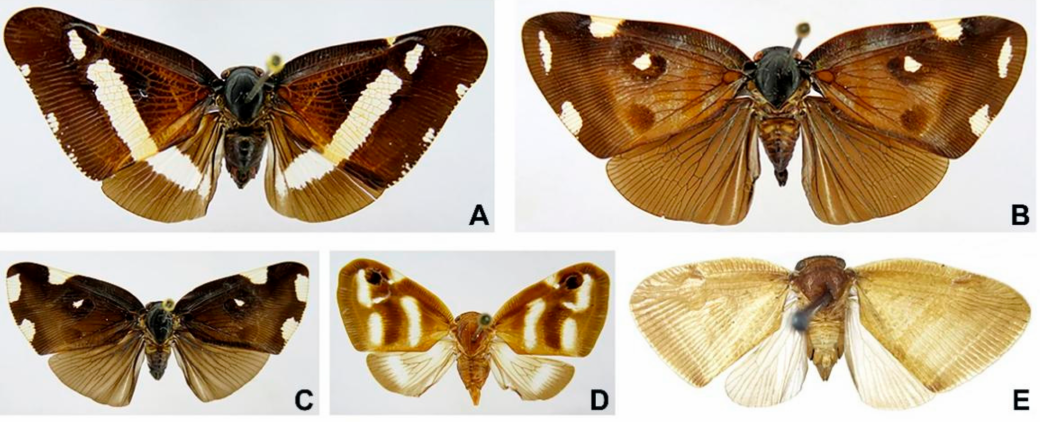
Figure 1. Photo plate of five Ricaniidae specimens. ( A ) Pochazia confusa , ( B ) Pochazia discreta , ( C ) Pochazia guttifera , ( D ) Ricania simulans , ( E ) Ricania fumosa